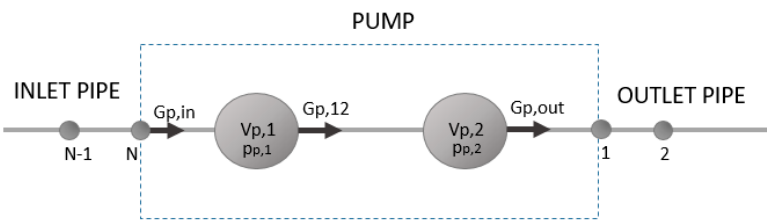
Figure 5. High-pressure booster pump mathematical model. Note: N, N-1—numbers of inlet pipe sections; 1, 2—numbers of outlet pipe sections; Vp,1—the passage between the pipe and the first stage of pump’s joint; Vp,2—the passage between the pipe and the second stage of pump’s joint; Gp—mass flow of LNG.